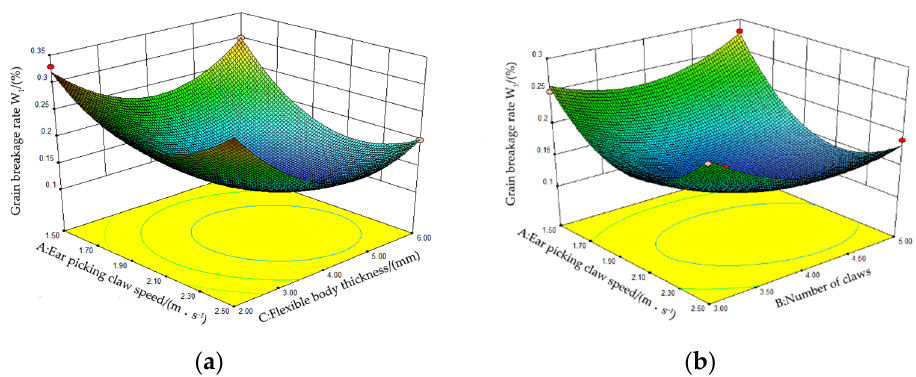
Figure 9. Effects of the interaction of factors on the grain breaking rate. ( a ) Interaction between ear picking claw speed and flexible body thickness; ( b ) interaction between ear picking claw speed and number of ear picking claws.